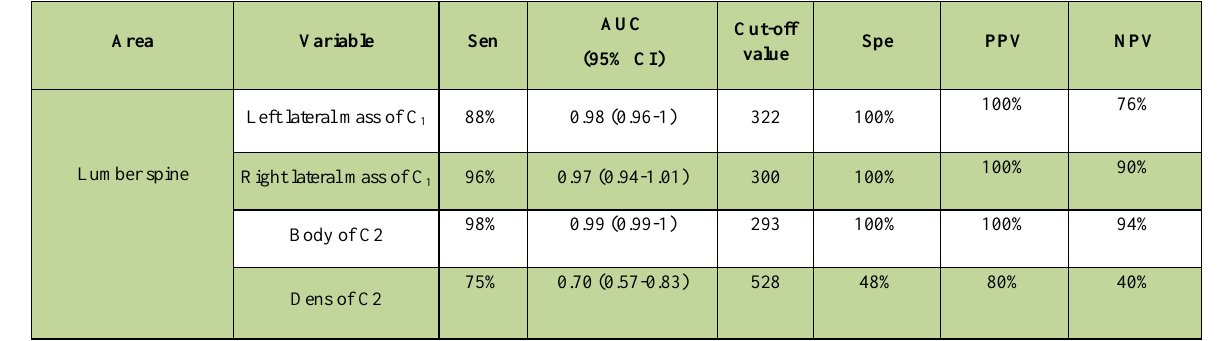
Table 4: Validity of the values of RD in the prediction of